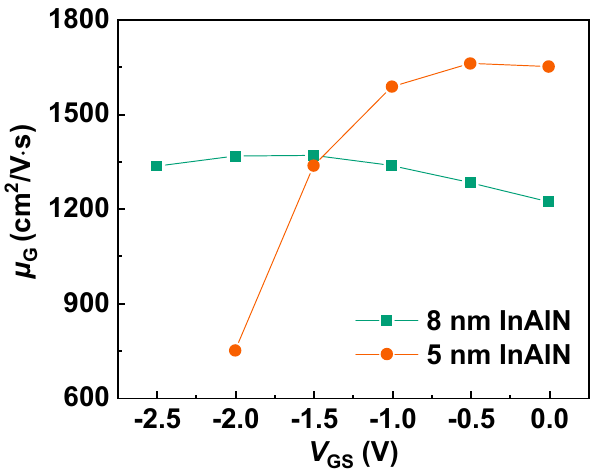
Figure 5. Extracted µ versus V GS of the devices with 8 nm and 5 nm InAlN.